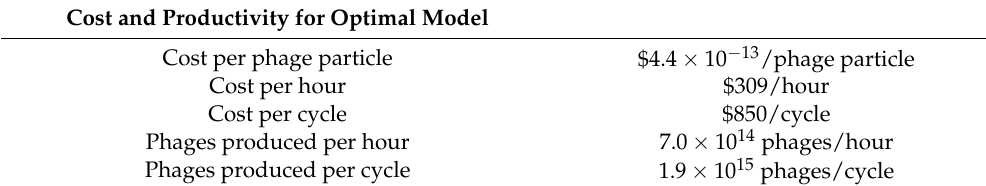
Table 4. Productivity and production costs for the optimal